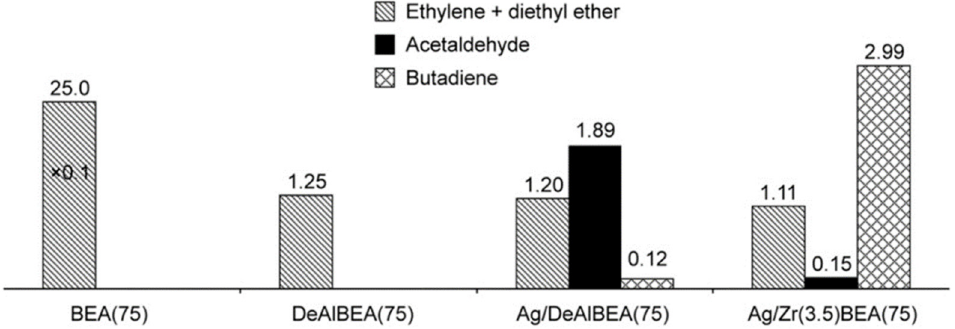
Figure 12. Initial formation rates of various products from the catalytic ethanol conversion over the BEA(75), DeAlBEA(75), Ag/DeAlBEA(75), and Ag/Zr(3.5)BEA(75) catalysts. Reprinted with permission from [63]. Copyright 2016 WILEY-VCH Verlag GmbH & Co. KGaA, Weinheim. The bimetallic ZnTa/BEA, CuTa/BEA, and AgTa/BEA zeolite catalysts were tested in